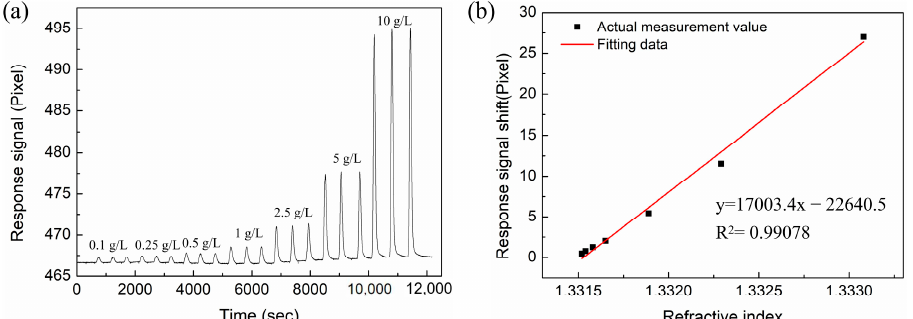
Figure 10. ( a ) The response curves of NaCl solution with different concentrations for the proposed biosensor based on two layers of MoS 2 . ( b ) The corresponding linear fitting line.